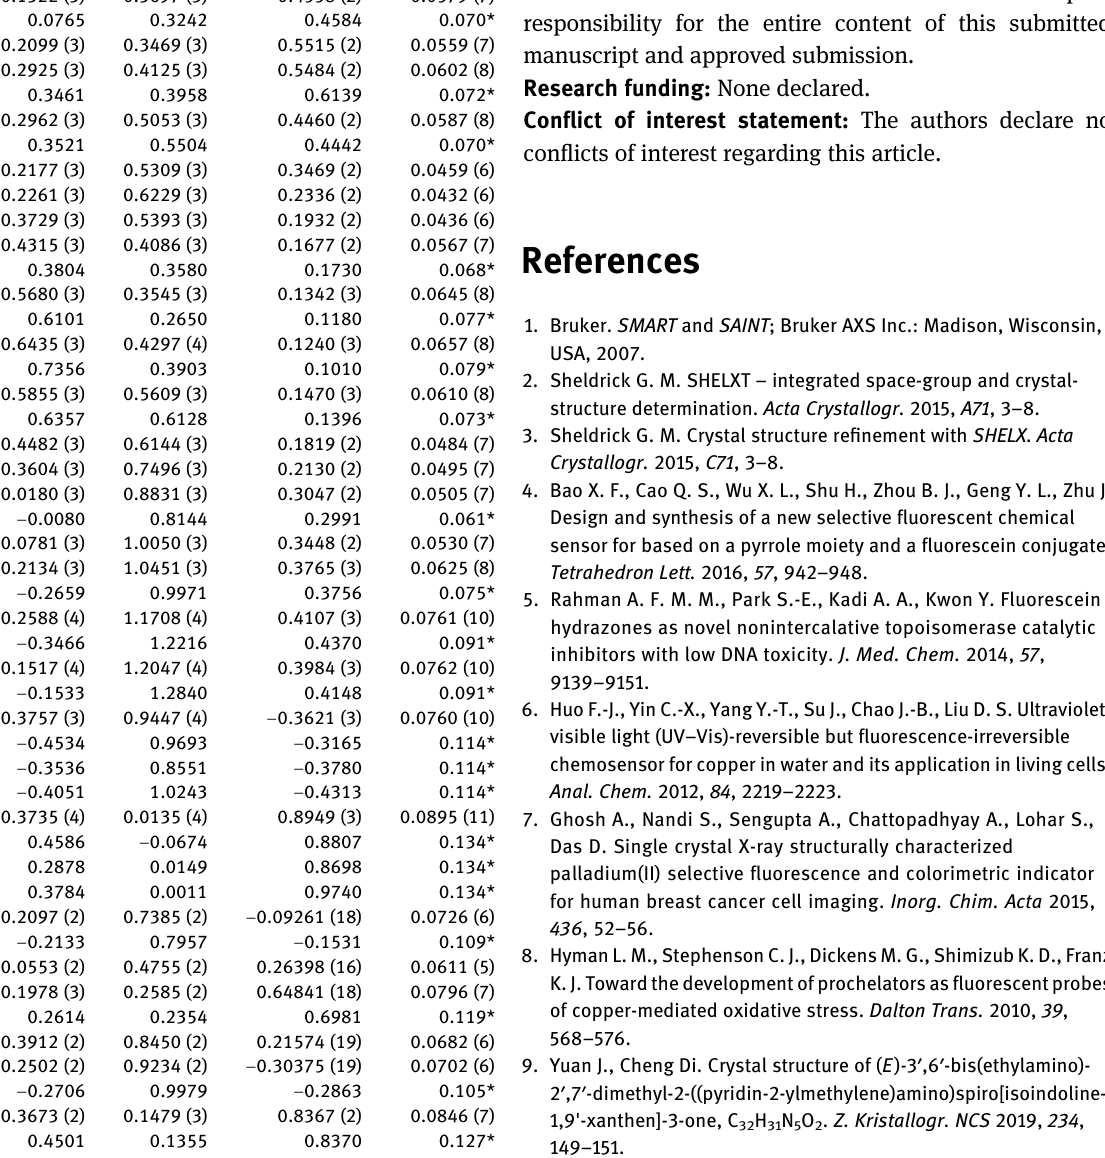
The asymmetric unit contains a neutral hydrazone molecule in a ring-closed form and two methanol mole- cules. The C20 = O4 bond distance is 1.235(3) Å, indicating the keto form of the amide. The bond length of C21 – N2 is 1.274(3) Å, suggesting the existence of the Schiff base C=N moiety. All bond lengths are in the expected ranges and comparable with those of reported fl uorescein hydra- zones [6 – 8] and a directly related spiro compound [9]. The dihedral angle between the least-square plane of the benzamide and pyrrole is 6.18 ° . In the solid state, hydrazone molecules are linked into a chain structure by methanol molecules via O – H ⋯ O and N – H ⋯ O hydrogen bonds.